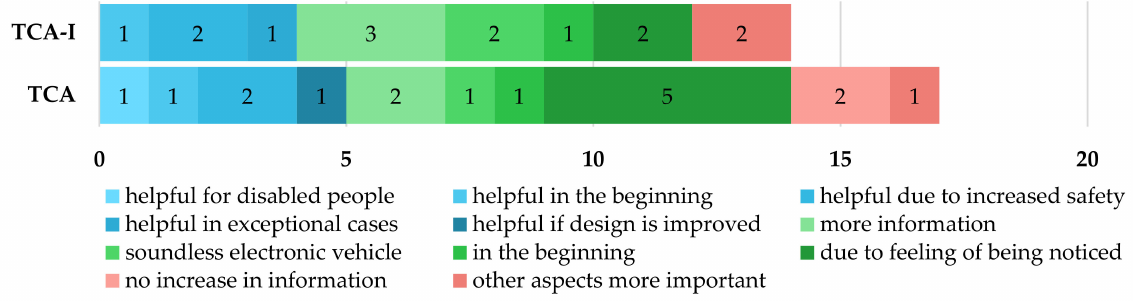
Figure 12. Perceived necessity of AV’s eHMI: distribution of results according to test condition. (Interview question